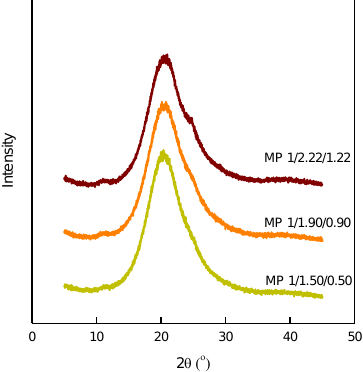
Figure 5. X-ray diffractograms of the bio-based SMTPUs.